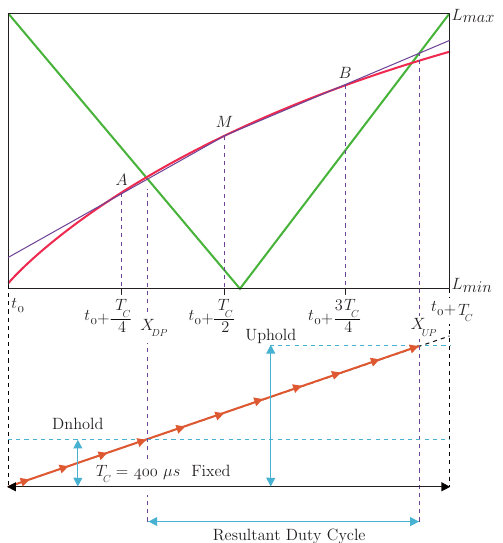
Figure 7. Generation of switching edges X DP and X UP